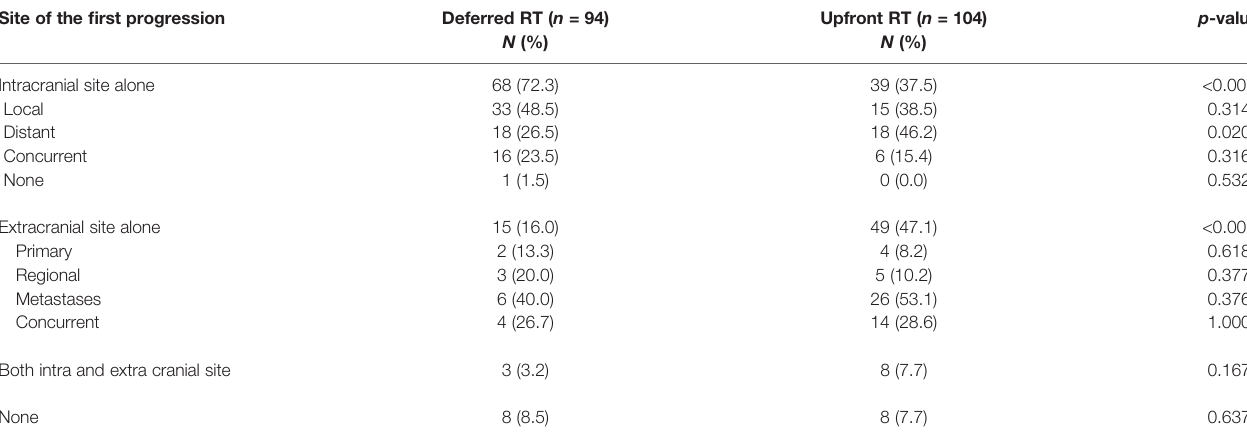
TABLE 2 | Patterns of failure in the entire